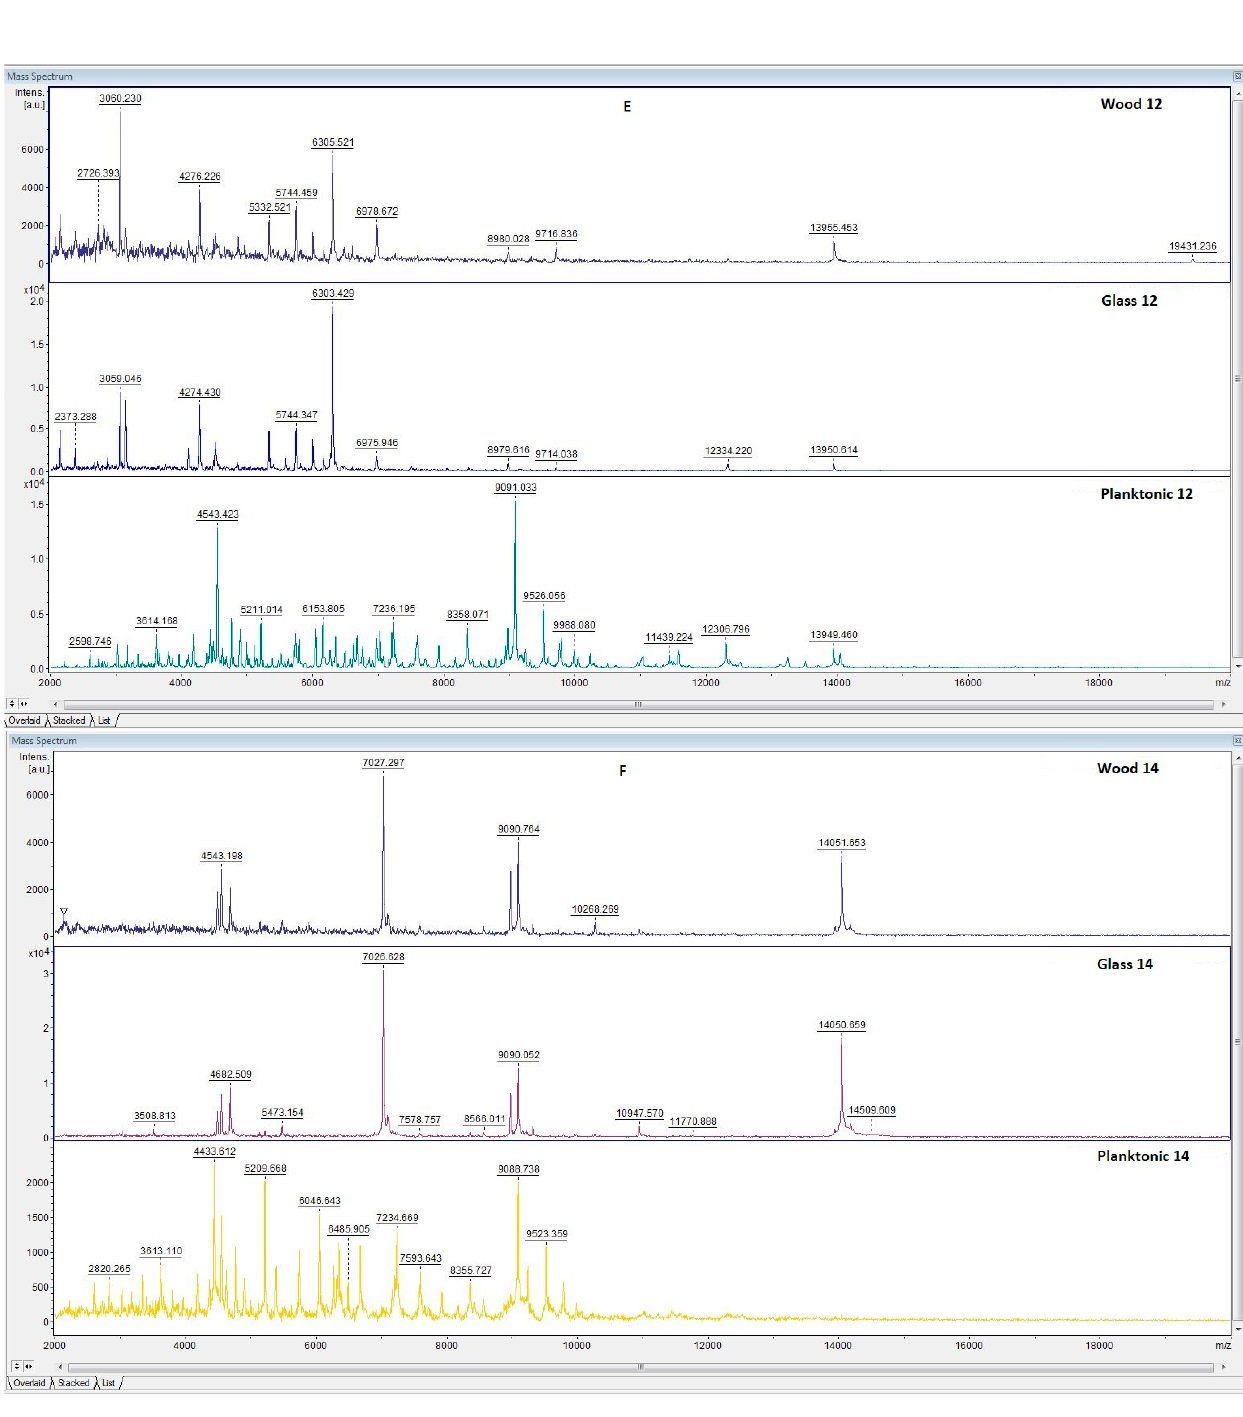
Figure 3. MALDI-TOF mass spectra of the biofilm produced by LGEO-treated S. enteritidis during development: ( A ) 3rd day, ( B ) 5th day, ( C ) 7th day, ( D ) 9th day, ( E ) 12th day and ( F ) 14th day. SE: S. enteritidis ; C: control; G: glass; W: wood and P: planktonic.